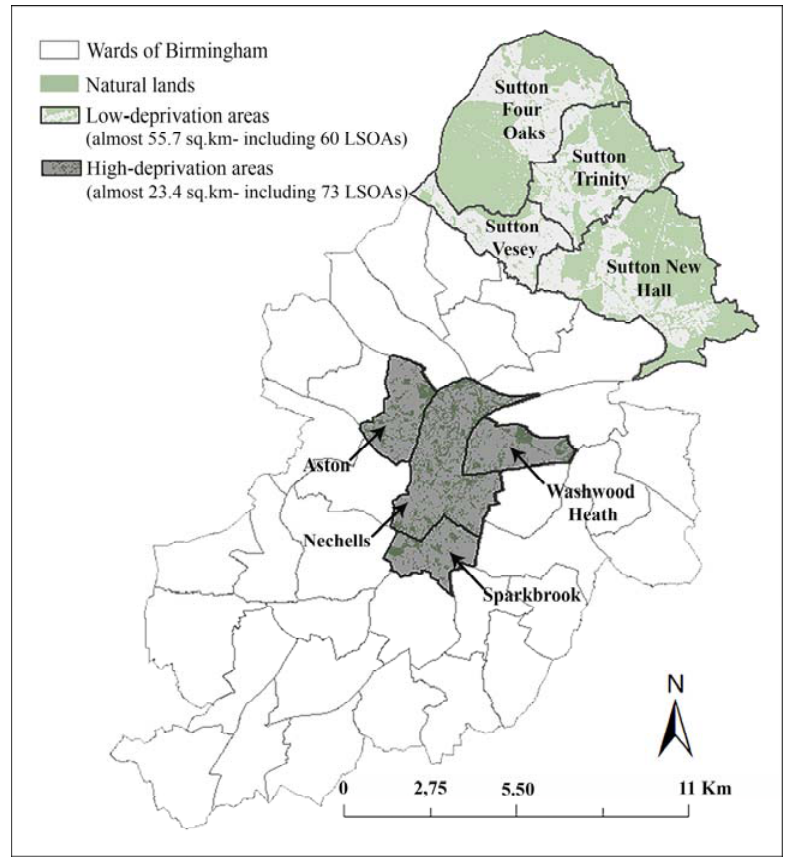
Figure 1. Locations of low ‐ and high ‐ deprivation areas in Birmingham. Adapted from [37].